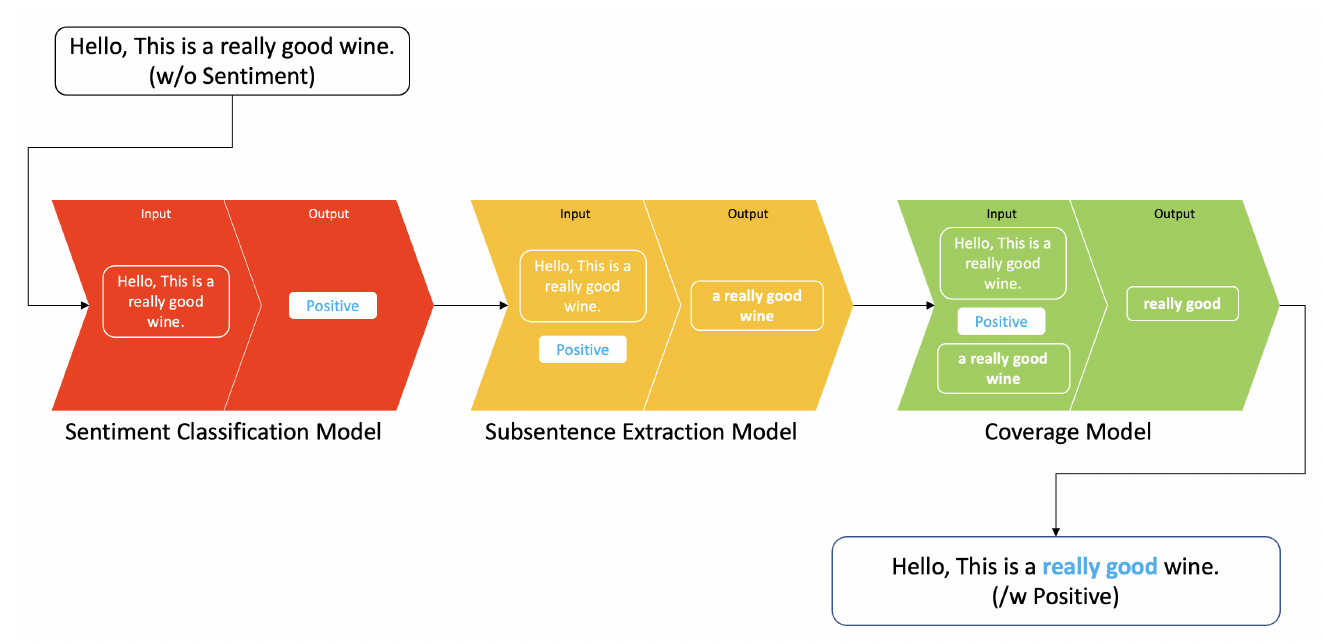
Figure 1. Processing pipeline with an example input sentence. There are three cascaded models to predict both sentiment and subsentence. Each model consists of a bidirectional transformer model with varying output